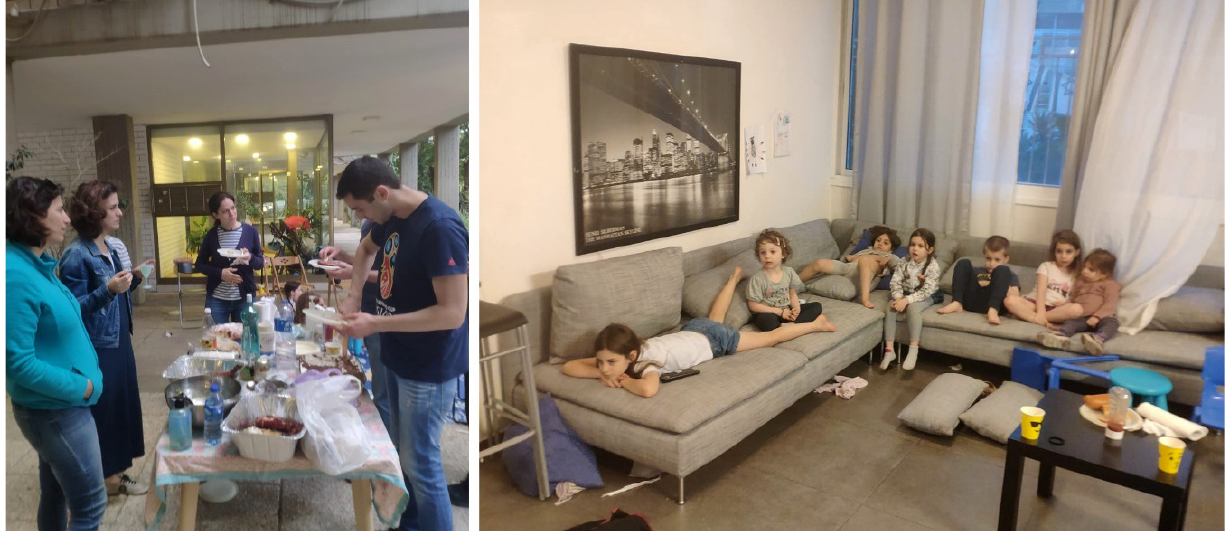
Figure 11. During the Covid‐19 pandemic lockdown residents celebrated holidays together and organized collective child‐ care